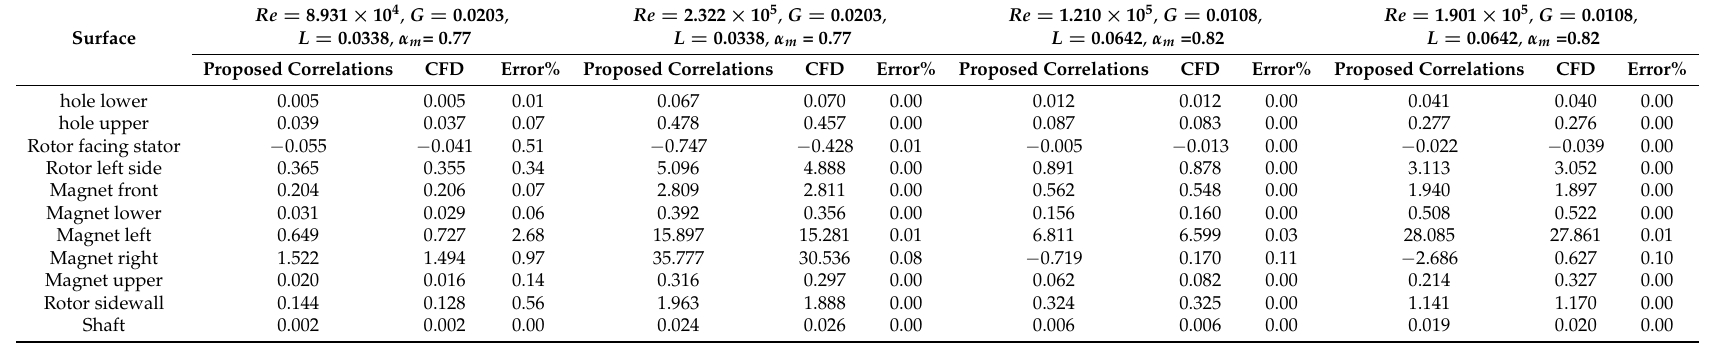
Table 3. Comparison between the CFD and the proposed correlations results for windage losses (W) at different cases when R r = 74 mm.